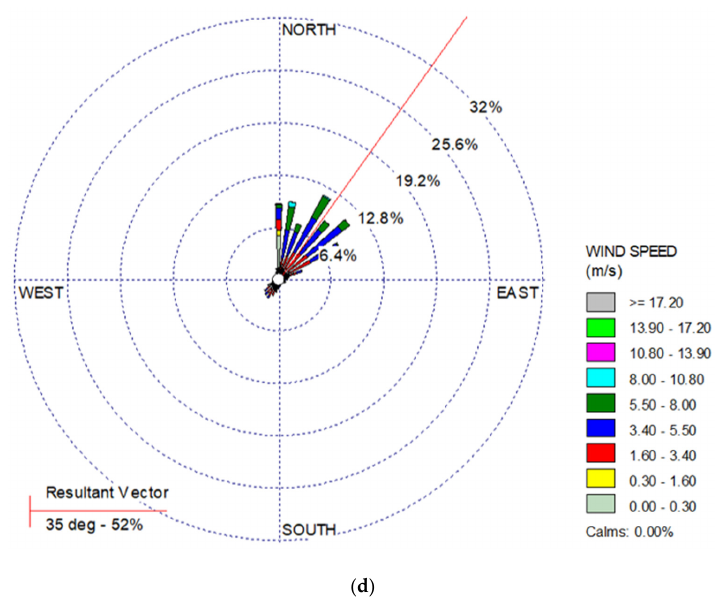
Figure 4. Relationships among relative humidity (RH), visibility obtained from Songsang Interna- tional Airport, urban heat island (UHI) effect, and sea–land breezes from 2016 to 2019 in the winter, October to April, in the Taipei metropolis: ( a ) Tamsui; ( b ) wind rose for Tamsui; ( c ) Keelung; ( d ) wind rose for Keelung.